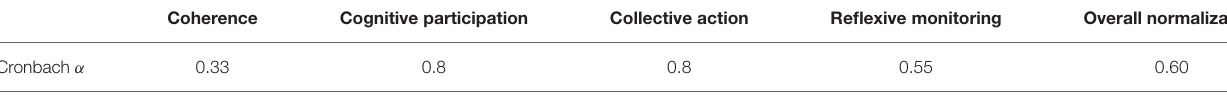
TABLE 3 | Reliability of NPT mechanisms.